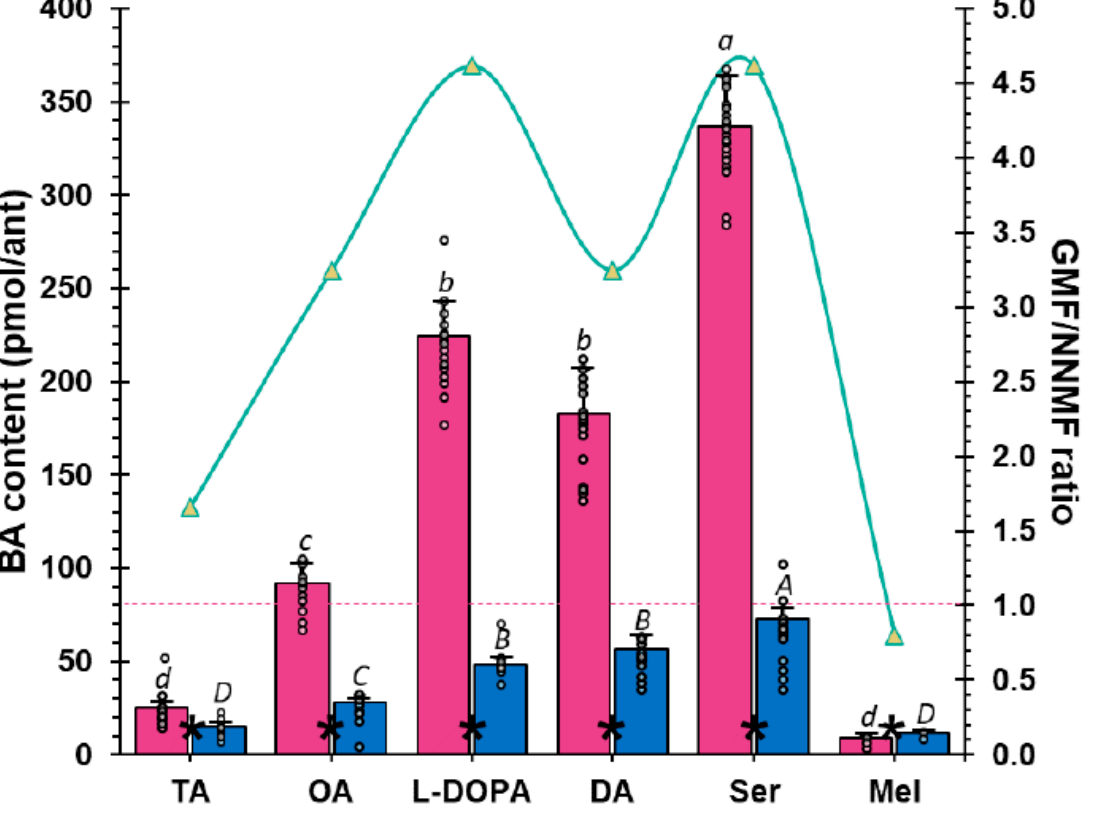
Figure 5. Differences in the average content of tyramine (TA), octopamine (OA), L-DOPA, dopamine (DA), serotonin (Ser), and melatonin (Mel) in black garden ants ( Lasius niger ) upon exposure to GMF (magenta bars) and NNMF (blue bars). Mean values are expressed as pmol · ant brain − 1 (N = 30). For each series (GMF and NNMF), different letters indicate significant differences ( p ≤ 0.05), as measured by Tukey's multiple interval test. The interpolation red line displays the GMF/NNMF ratio. The asterisk indicates a statistical difference between GMF and NNMF in the content of the relative BA. Metric bars indicate standard deviation. For further statistical analysis, see Supplementary Table S2.